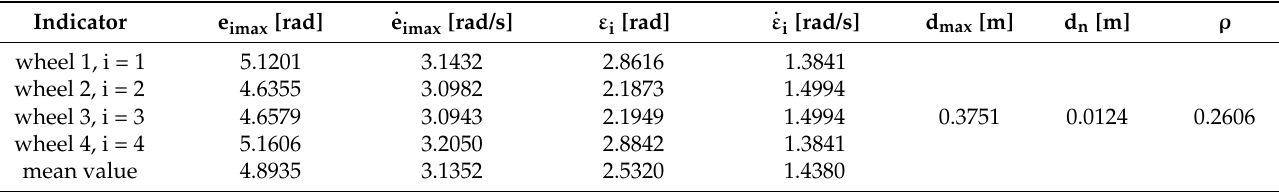
Table 3. Quality indicators for PD control verification.